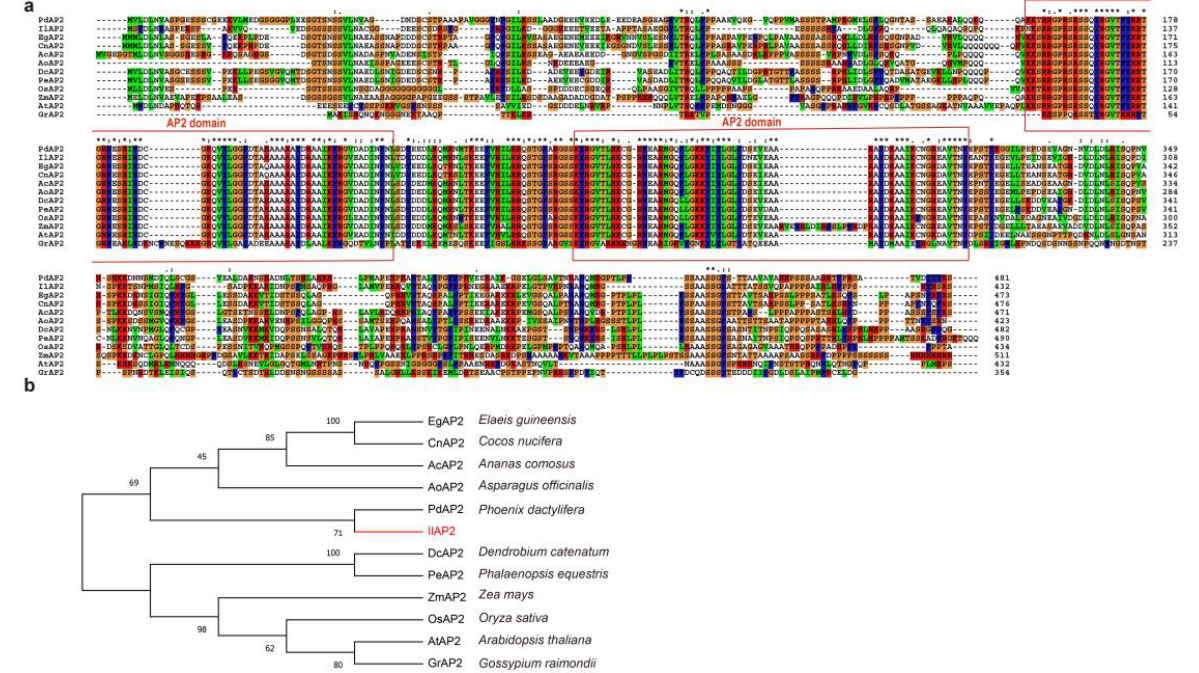
Figure 1. Analysis of the AP2 sequence: ( a ) alignment result of IlAP2 amino acid sequence (the red boxes represent functional domains, '*' indicates positions which have a single, fully conserved residue); and ( b ) phylogenetic tree of AP2 proteins from I. lactea (IlAP2) and other species.